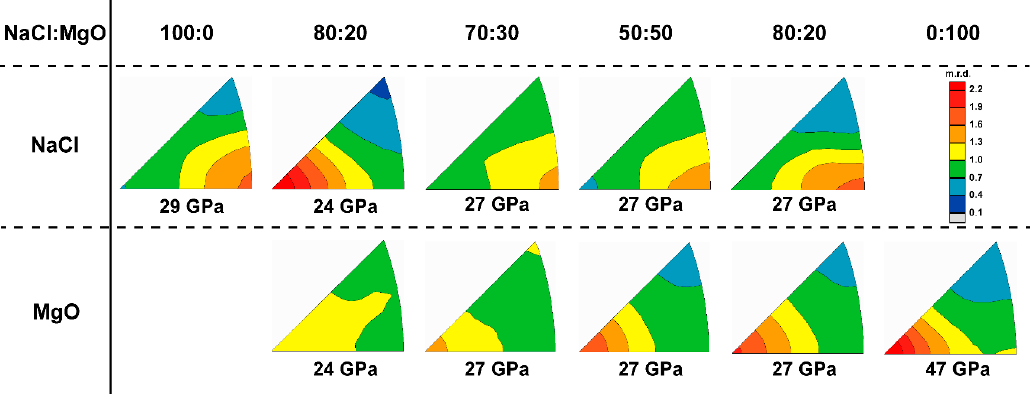
Figure 19. Summary of experiment texture with various phase proportion.